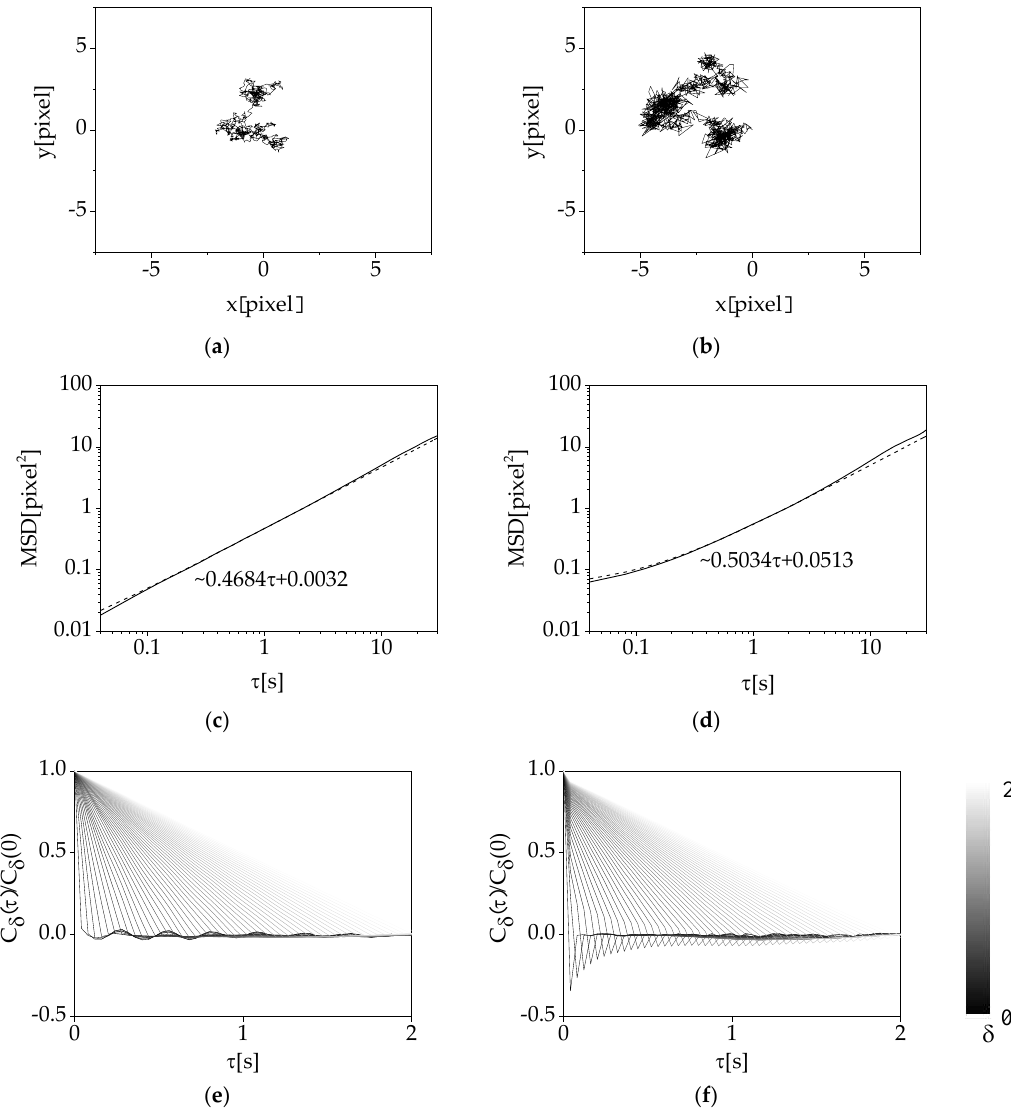
Figure 2. Representative trajectories of random motion of ( a ) cPMS and ( b ) MCF-7 cells calculated using the radial symmetry method. The ensemble-averaged MSDs of ( c ) cPMS and ( d ) MCF-7 cells calculated from the trajectories and the VACFs of ( e ) cPMS and ( f ) MCF-7 cells, δ from 0.04 to 2 s (black to white).